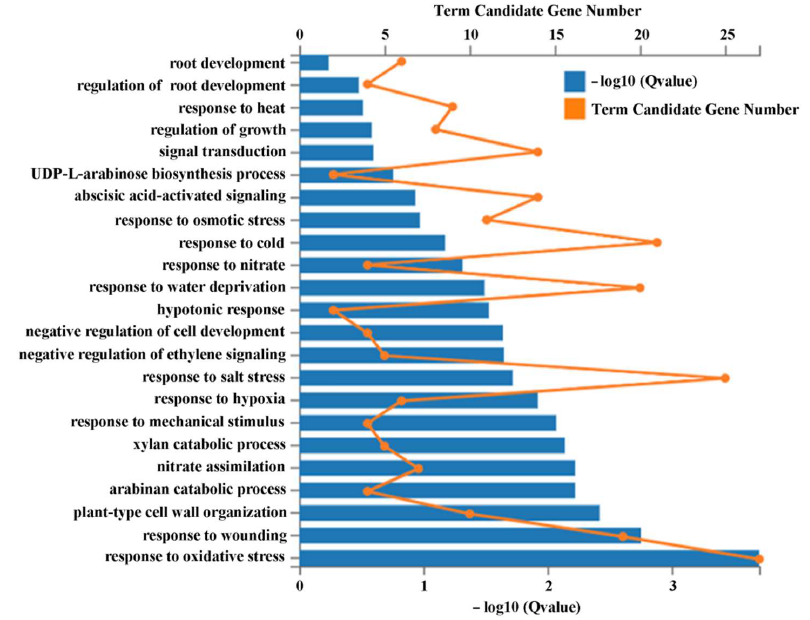
Figure 7. Functional classification of the DEGs. The DEGs that were down-regulated in the 35S : ASR1 #19 transgenic plants and up-regulated in the asr1 asr2–c25 double mutants were subjected to functional gene ontology (GO) under the term of biological process. The GO annotation enrichment of DEGs analysis was evaluated using the phyper function in the R program. Significant enrichment was defined as GO keywords with a Q value (adjusted p value) <0.05. plants but increased expression levels in the asr1 asr2 double mutants, several genes in- cluding MTO 1 Responding Down 1 ( MRD1 ), Threonine Aldolase 1 ( THA1 ), Exordium Like 2